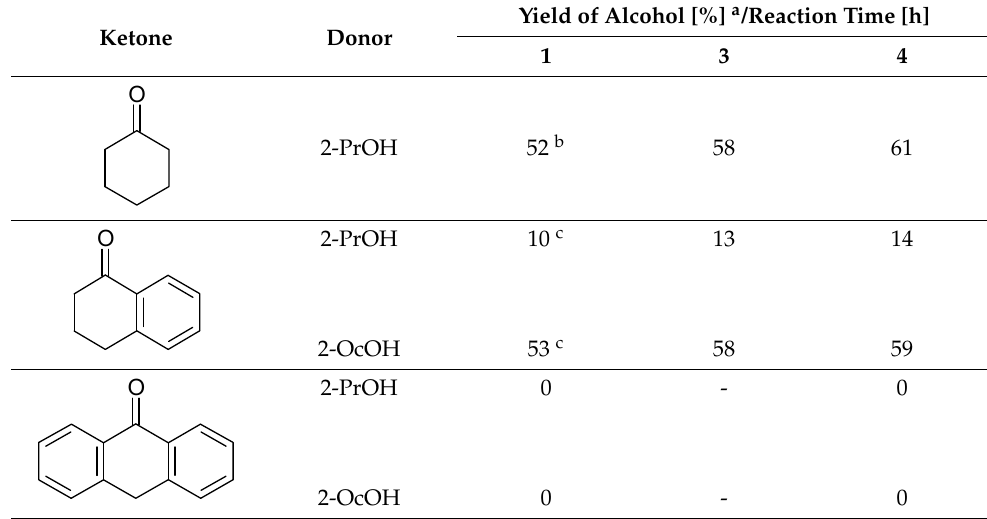
Table 5. Liquid phase transfer hydrogenation of polycyclic derivatives of cyclohexanone with secondary alcohols in the presence of MgO.